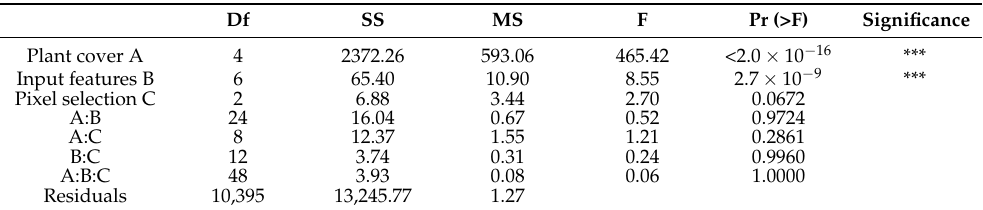
Table 3. Results of thee-way ANOVA for the factors plant cover (A), input features (B), and pixel selection (C) and all combinations of possible interactions. Analysis was performed on the logit transformed segmentation quality Q T seg (see Equation (4)). Columns show degrees of freedom (Df), sum of squares (SS), mean squares (MS), F-value (F), p -value Pr( > F), and significant factors at α = 0.05 ***. Df SS MS